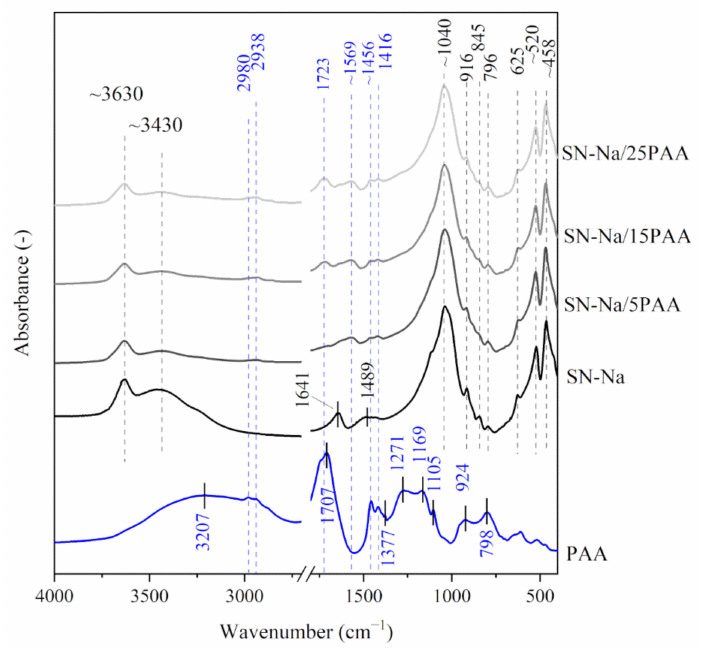
Figure 3. IR spectra of starting materials SN-Na and PAA used in the preparation of composite materials with different polymer contents: SN-Na/5PAA, SN-Na/15PAA, SN-Na/25PAA. The IR spectra of poly(acrylic acid) displayed a band with a large half-width in the wavenumber range of 3500–2500 cm − 1 , which indicated the presence of intramolecular hydrogen bonds within the carboxyl group (3207 cm − 1 ) (PAA, Figure 1) [42,43]. The bands with a maximum at 2980 and 2938 cm − 1 were assigned with the C–H stretching vibra- tions [42,44–46]. The maximum of the highest intensity band at 1707 cm − 1 was attributed to the stretching vibrations of the carbonyl group C=O, typical for PAA [30,47,48]. The ab- sorption bands characteristic for the long carbon chains at 1456 and 1105 cm − 1 were